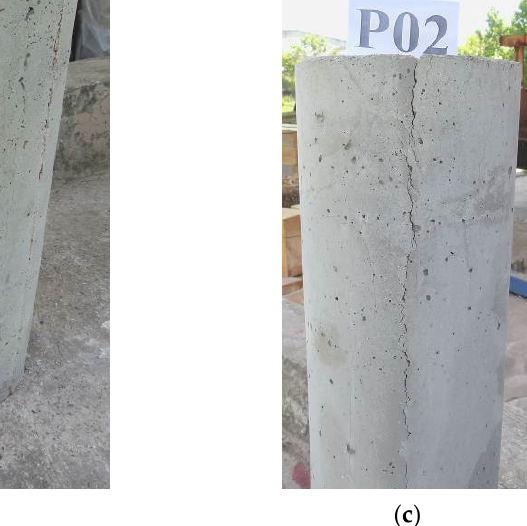
Figure 18. Strengthened specimens after removing steel tubes ( a ) and cracks in fill concrete—diagonal ( b ) and longitudinal ( c ).